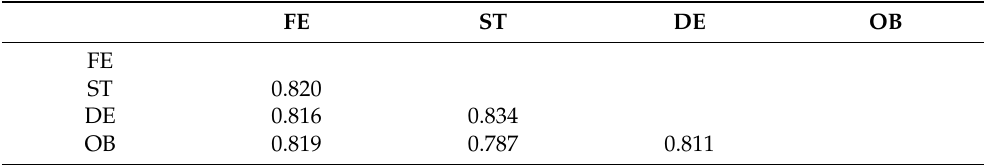
Table 6. Heterotrait–monotrait ratio